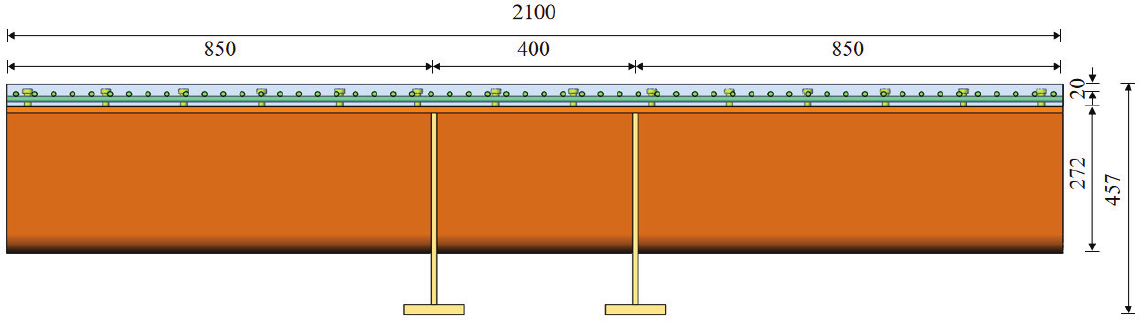
Figure 3. Schematic diagram of the structure of steel–UHPC composite beam test specimen (unit: